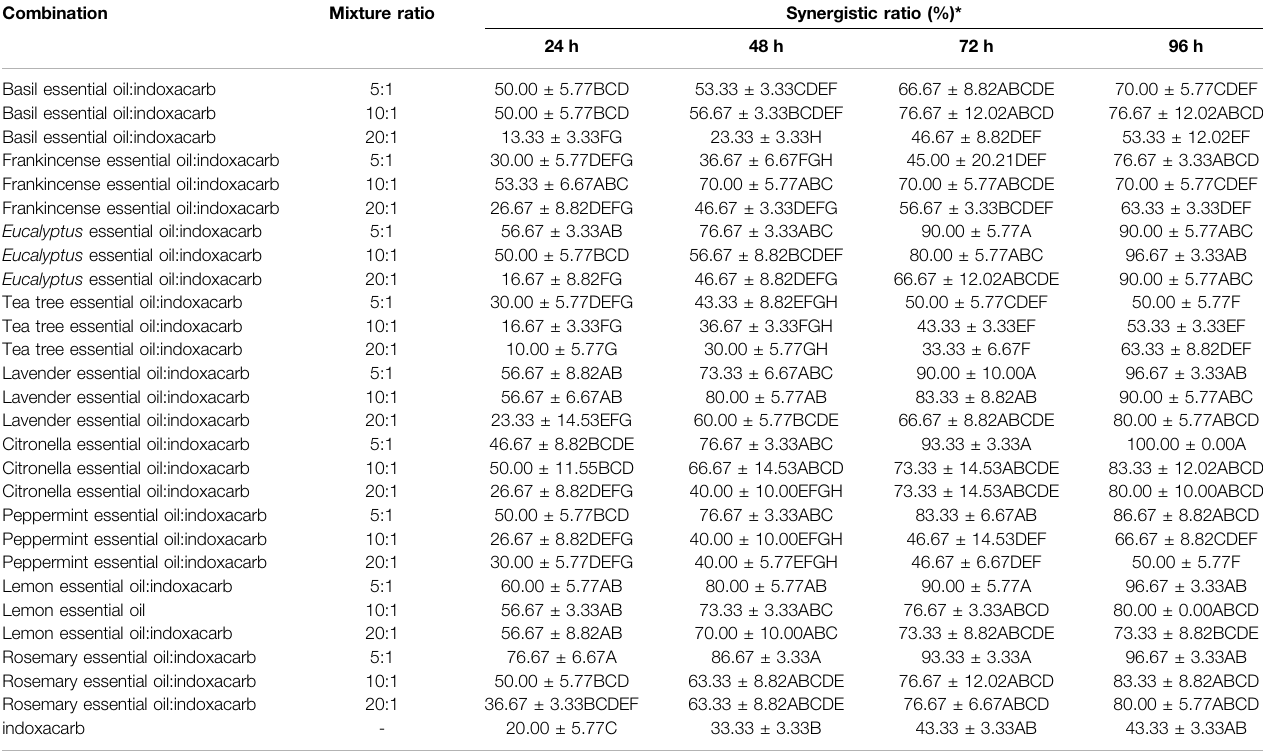
TABLE 4 | Synergistic effects of different plant essential oils and indoxacarb. Combination Mixture